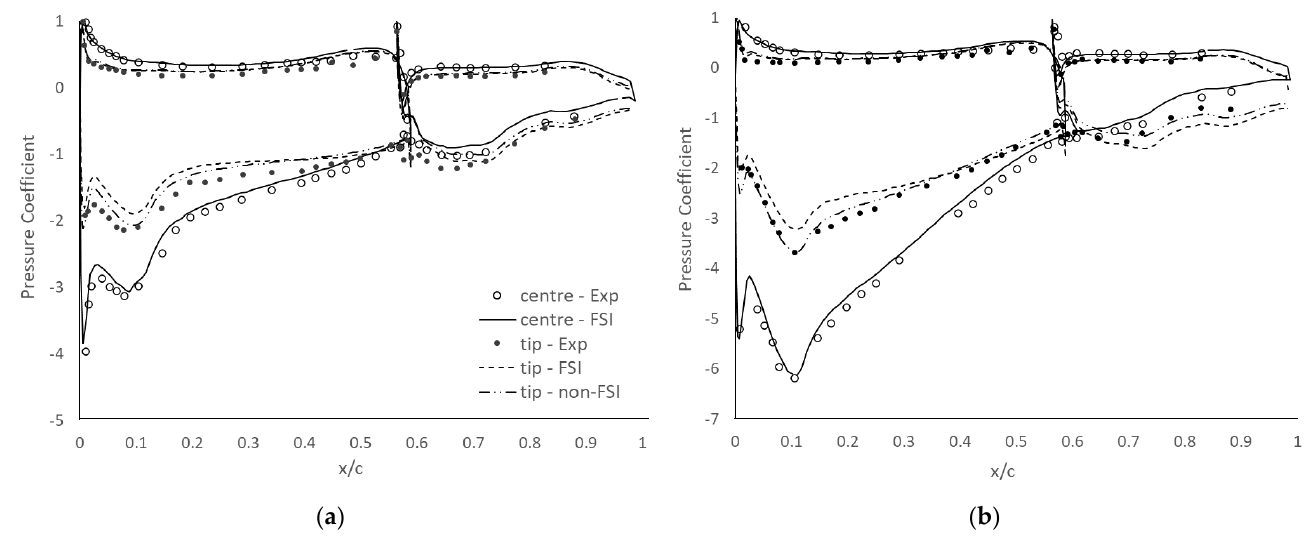
Figure 7. Chordwise surface pressure at wing centre and wing tip: ( a ) h/c = 0.395, ( b ) h/c = 0.105.